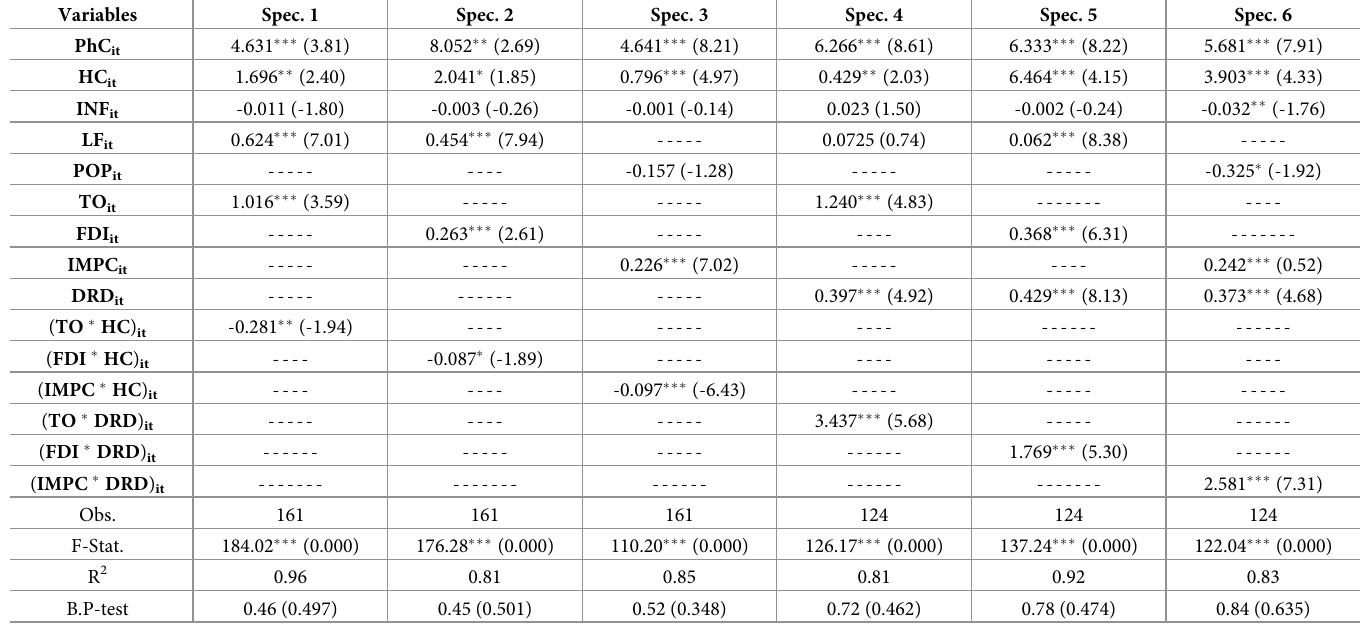
Table 1. Estimated results (dependent variable is GDP